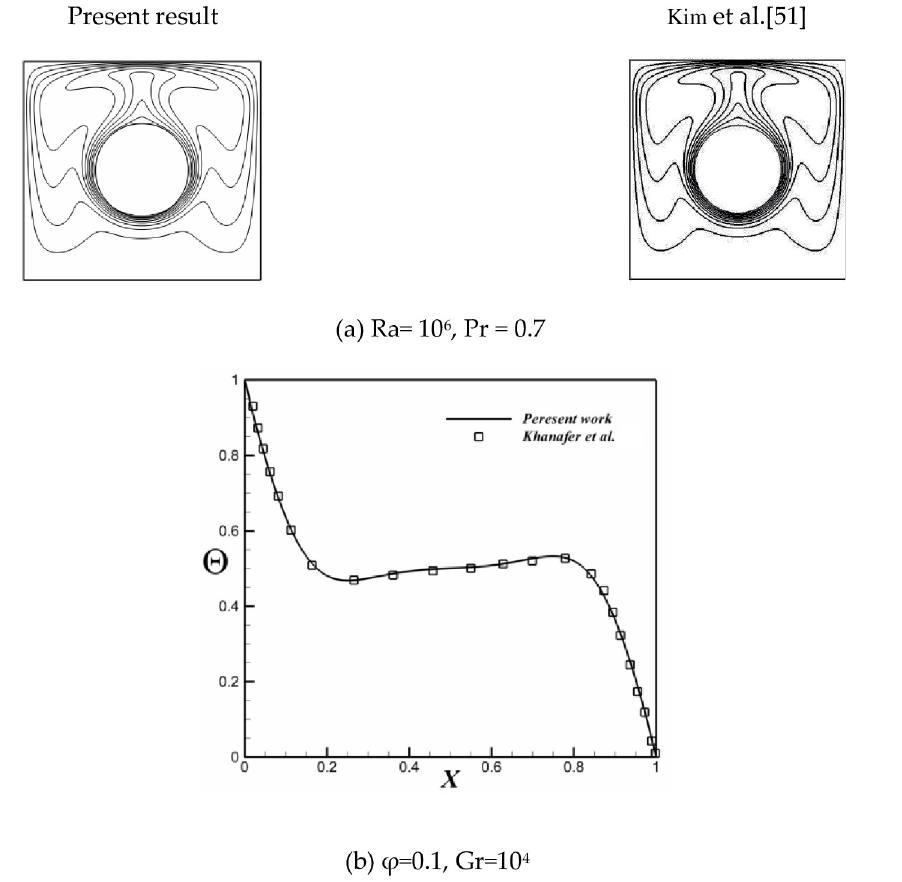
Fig 2. Validation for (a) free convection (Kim et al. [51]) (b) nanofluid (Khanafer et al. [52]). https://doi.org/10.1371/journal.pone.0251744.g002 The estimations of the further parameters used are Ra = 10 5 , Da = 0.01, Rd = 0.8. It is found that the strength of the Isotherm contours augments with the growing magnetic effect. Thus the heat of the inner wall enhances due to the inter-particle collisions with higher magnetic fields. The right plots show that the strength of the vortexes of the Streamlines decreases with augmenting Ha. Hence the convective hybrid nanoliquid flow reduces with the higher Lorentz forces. Fig 5 depicts the impact of varying Lorentz forces on the Isotherms and Streamlines of the hybrid nanofluid through contour plots. In this case, the permeability of the porous cylinder has increased by taking the value of Darcy number, Da = 100. The first two plots of Fig 5 are designed for Ha = 0 whereas the last two plots are represented for Ha = 20. The estimations of the other parameters used are Ra = 10 5 , Rd = 0.8. It is found that the strength of the Isotherm contours enhances with the augmenting magnetic field which